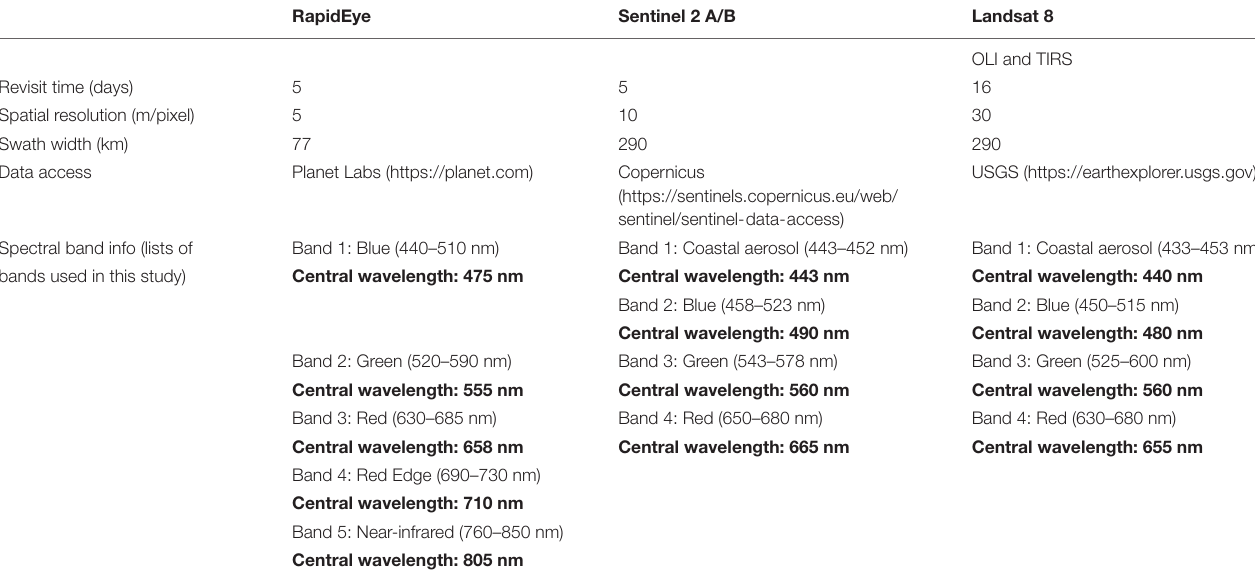
TABLE 1 | Optical satellite specifications for RapidEye, Sentinel-2 A/B, and Landsat